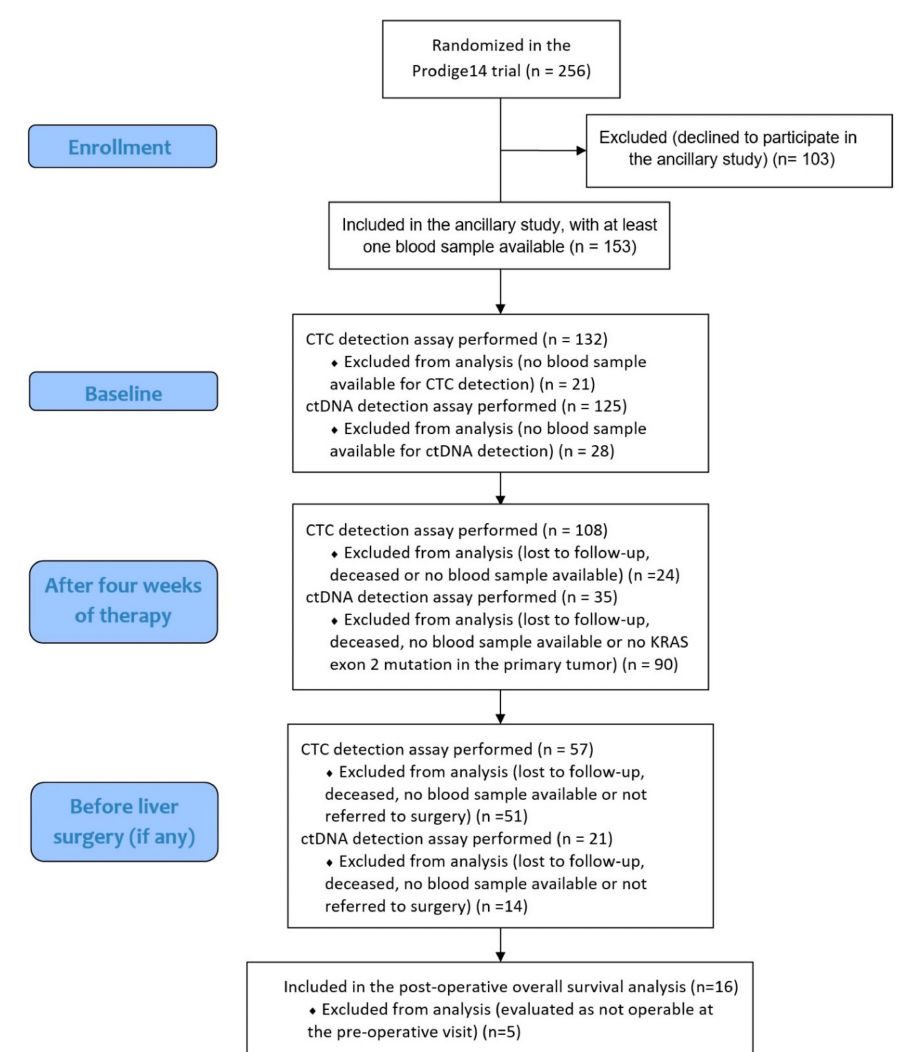
Figure 1. Flow chart of patients included in the analyses at the di ff erent time points.